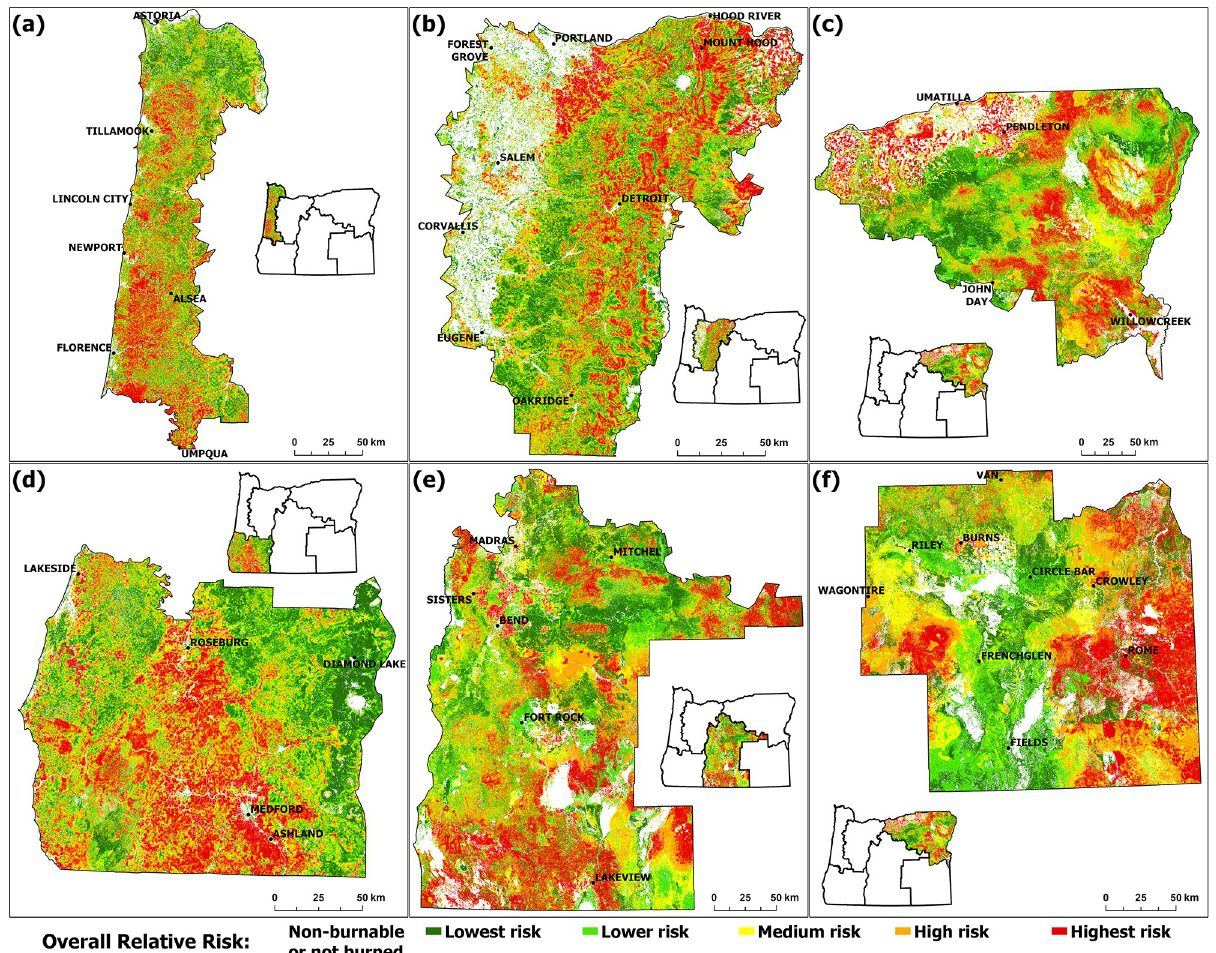
Fig 8. Spatial distribution of overall relative risks in FSA1 to FSA 6 (panel a to f). Transparent areas show grid cells that were classified as non- burnable or not burned by the fire model and consequently have no risk values assigned.